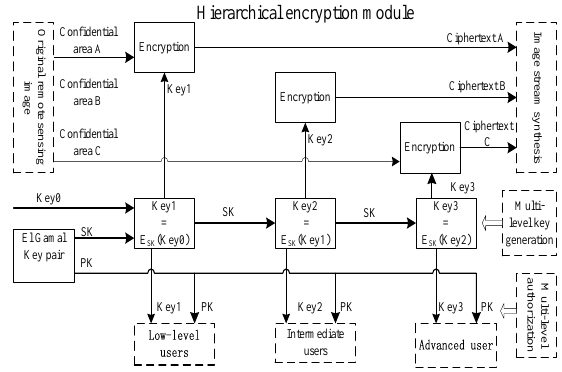
Figure 3. The architecture of multi-level security